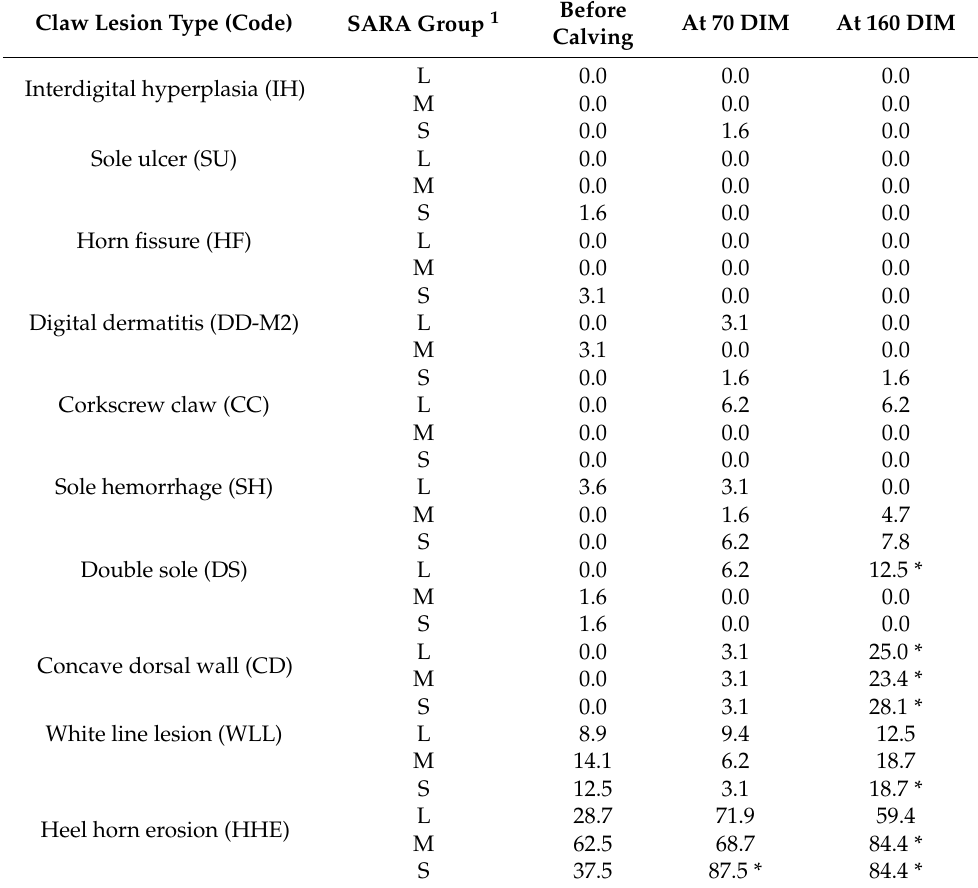
Table 4. List of prevalence values in percentage (at claw level) of recorded claw lesions in the three SARA groups before the start of the study (8 weeks before calving), at the end of the SARA diet (70 DIM) and three months later (160 DIM) after the SARA diet was